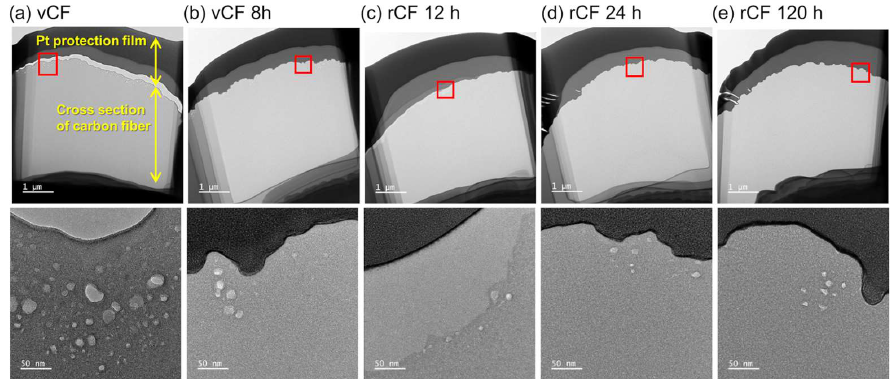
Figure 7. Results of TEM image of the cross-section for ( a ) vCF, ( b ) vCF 8 h, and rCF ( c ) 12 h, ( d ) 24 h, and ( e ) 120 h. Table 2. Presence ratio of voids existing inside vCF and rCF.